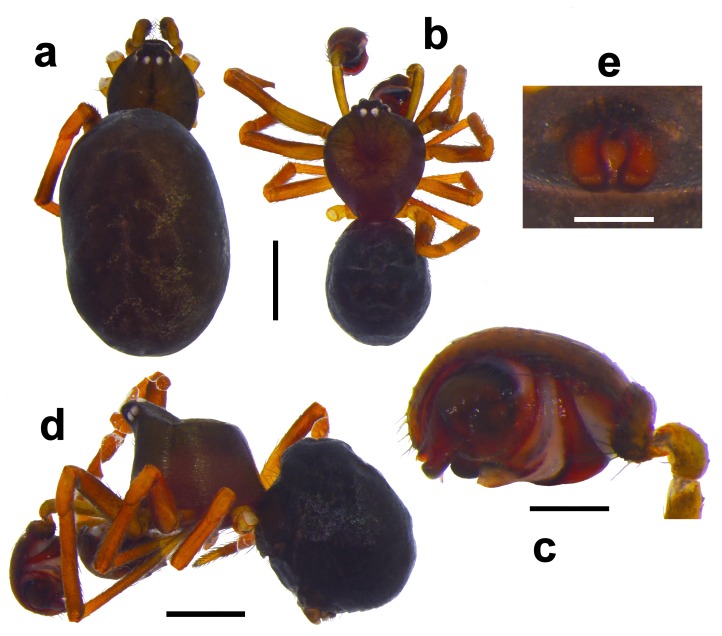
Dipoena
torva (Thorell, 1875). a: female, dorsal habitus, scale = 0.8 mm; b: male, dorsal habitus, scale = 0.8 mm; c: male, lateral habitus, scale = 0.6 mm; d: female epigynum, ventral, scale = 0.2 mm; e: left male palp, retrolateral, scale = 0.2 mm.